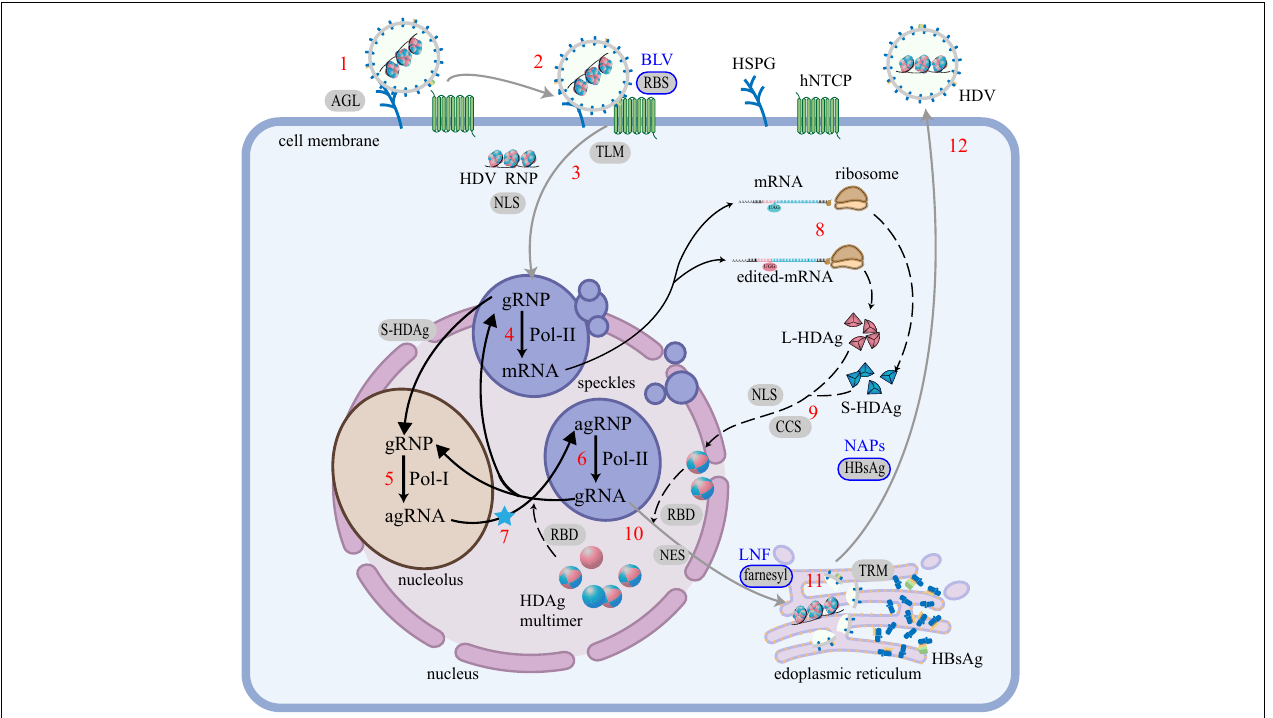
FIGURE 5 | HDV life cycle and the regions that drive each step. The life cycle of HDV is mainly divided into 5 steps: (i) De novo entry, (1) attachment; (2) recognition; (3) entry into cells; (ii) RNA amplification, (4) mRNA transcription; (5) agRNA replication; (6) gRNA replication; (7) RNA editing (blue star); (iii) HDAg production, (8) translation; (9) modification; (iv) Assembly, (10) HDV RNP assembly; (11) HDV particles assembly; (v) Secretion, (12) secretion. Black words mark cell or virus components, red numbers mark life cycle steps, words on the gray background mark the regions that drive the step and the blue border marks the regions that have been applicated to HDV therapy, blue words mark the corresponding therapies. The gray line represents the migration of the virus, the solid black line represents the migration of the RNA, and the black dashed line represents the migration of the protein. Regions of HDAg: RBD, RNA-binding domain; CCS, Coiled-coil sequence; NLS, Nuclear localization signal; NES, Nuclear export signal; farnesyl, farnesyl lipid group. Regions of HBsAg: RBS, Receptor-binding site; TLM, Translocation motif; AGL, Antigenic loop; TRM, Try-rich motif. Cell or virus components: HSPG, heparan sulfate proteoglycans; hNTCP, human sodium taurocholate coreceptor peptide; gRNA, genomic RNA; agRNA, antigenomic RNA.